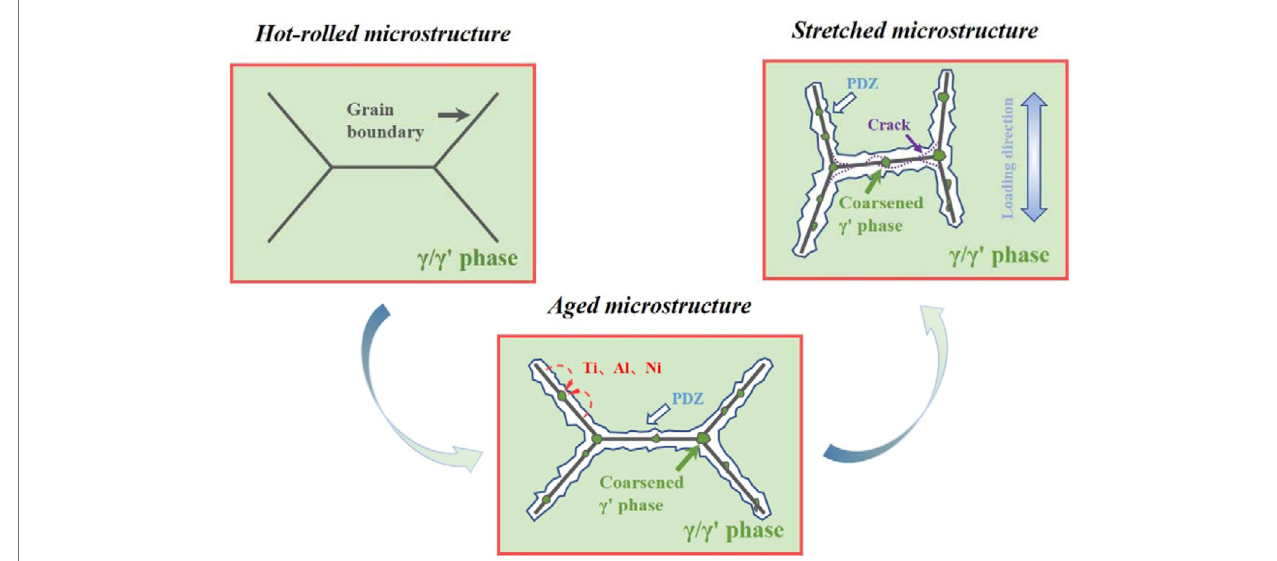
FIGURE 12 | Schematic diagram of microstructure evolution during isothermal aging